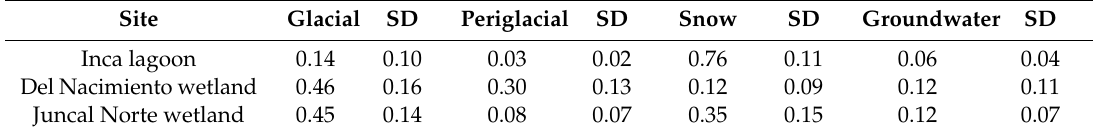
Table 5. Proportional contribution of each water source to the stagnant waters of the head catchments at the Aconcagua River basin according to “simmr”